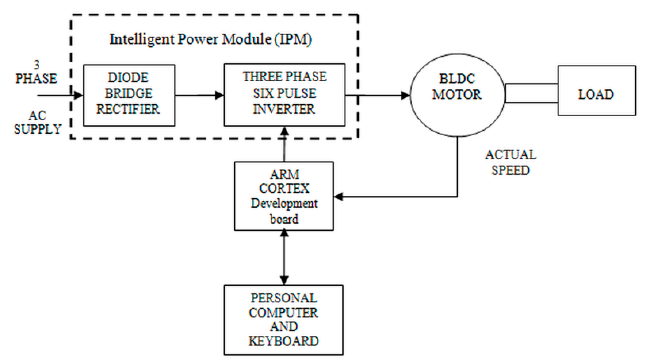
Figure 19. Block diagram of real-time BLDC motor drive system.